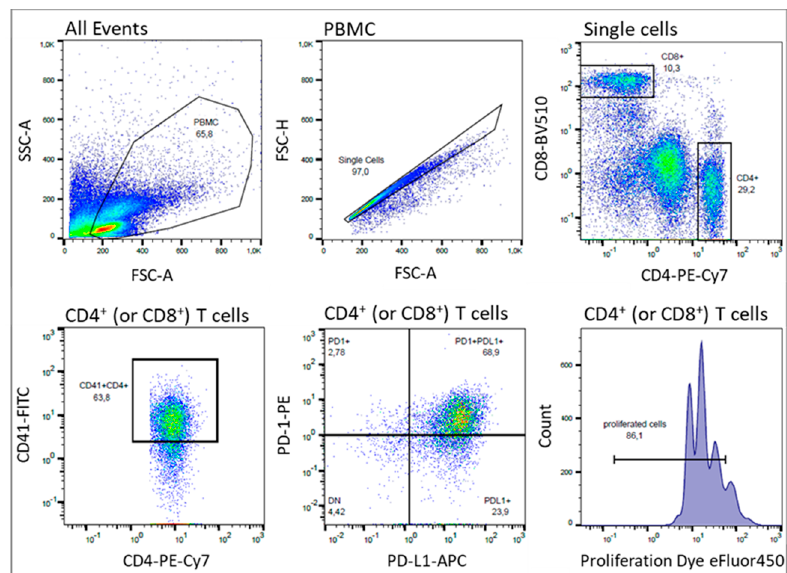
Figure 1. Gating strategy for the flow cytometric analysis of human T cells, platelets and their subpopulations. A single-cell suspension was stained with fluorochrome-conjugated antibodies against CD4-PE-Cy7, CD8-BV-510, PD-1-PE, PD-L1-APC, and CD41-FITC. Furthermore, freshly isolated PBMC were stained with Cell Proliferation Dye eFluor 450 before starting of culture. Data were collected with a MACSQuant flow cytometer and analyzed with FlowJo Software. Lymphocytes were identified by their scatter properties (FSC-A × SSC-A plot) and doublets were excluded by gating on FSC-A × FSC-H. CD4+ or CD8+ cells represent T-cell subsets. Expression of PD-1, PD-L1 and proliferation was investigated on CD4+ as well as CD8+ T cells, but is representatively shown only for CD4. Platelet-T cell aggregate formation was determined by the positivity of the platelet-specific marker CD41 on T cells.